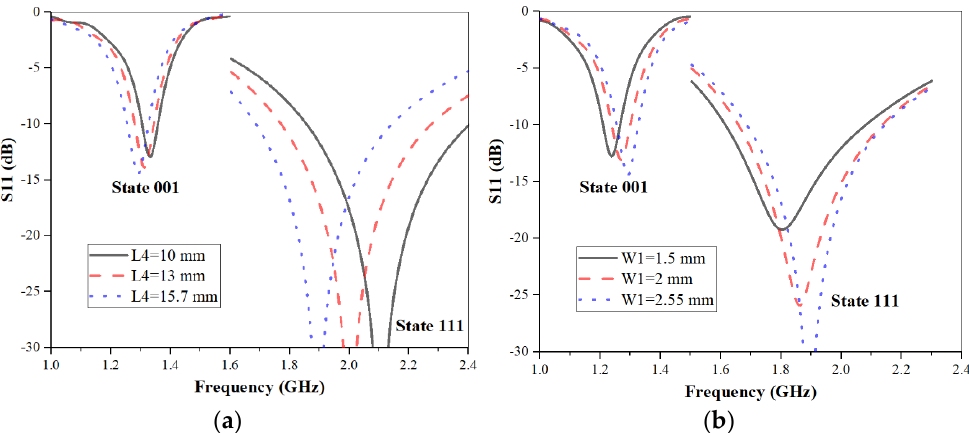
Figure 6. Simulated characteristics of reflection coefficient at state 001 and 111 for different values of L 4 ( a ) and w 1 ( b ).